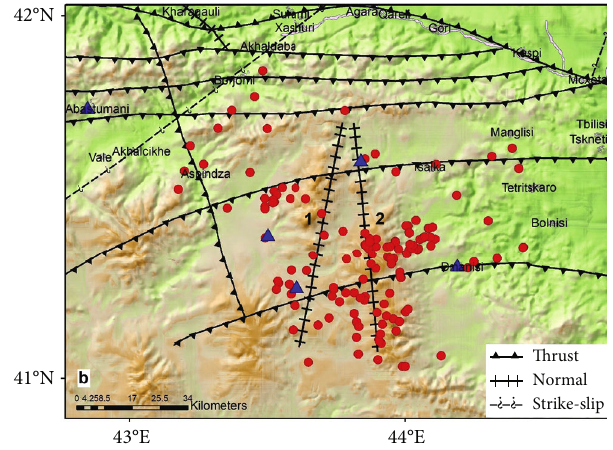
Figure 2: Map of epicenters of earthquakes (solid circles) and seismic stations (triangles) used in the present study. Types of faults are also shown. 1-Samsari,